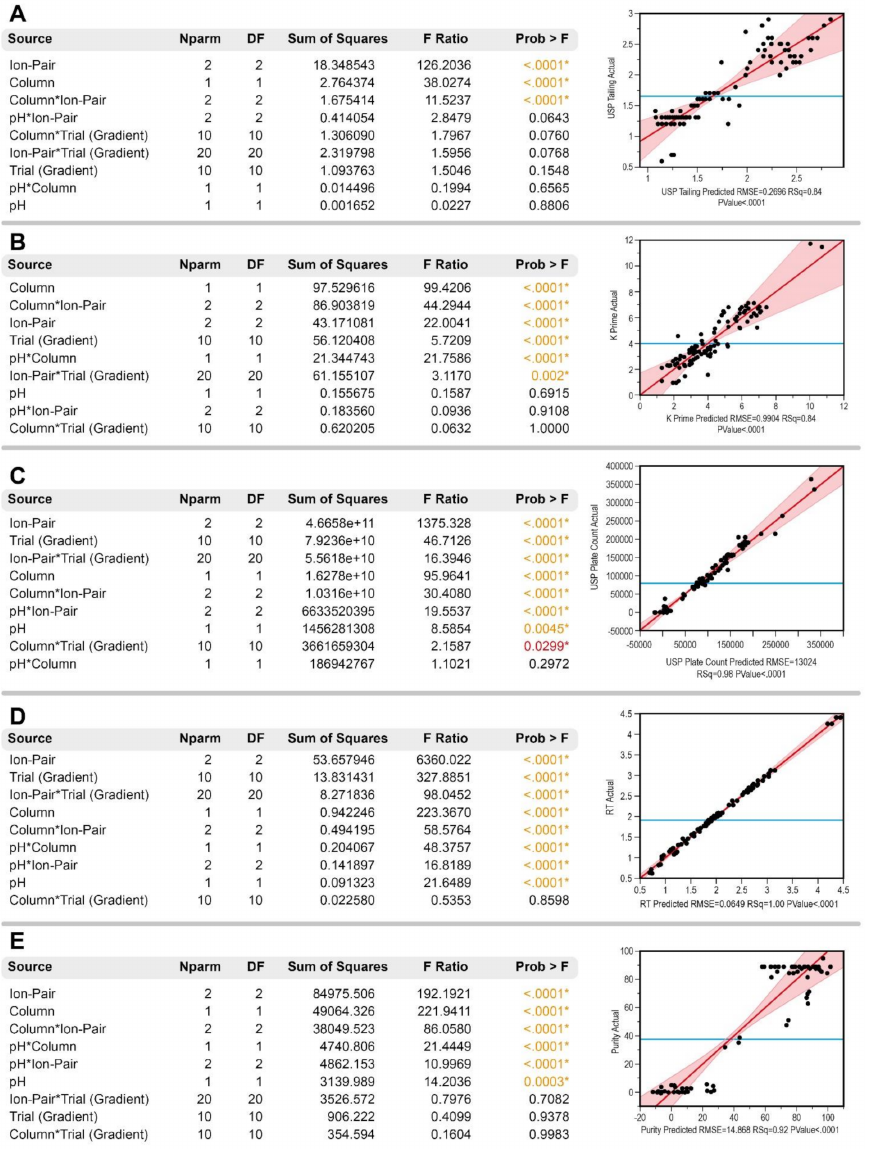
Figure 4. Effect tests (Being Nparm = number of parameters associated with this effect; DF = degree of freedom) and actual vs. predicted plot for USP tailing ( A ), K prime ( B ), USP plate count ( C ), retention time ( D ) and peak purity ( E ). Each black dot in the predicted vs. actual figure represents a data point with the mean (blue line) and 95% confidence interval (red shaded area around the red linear regression